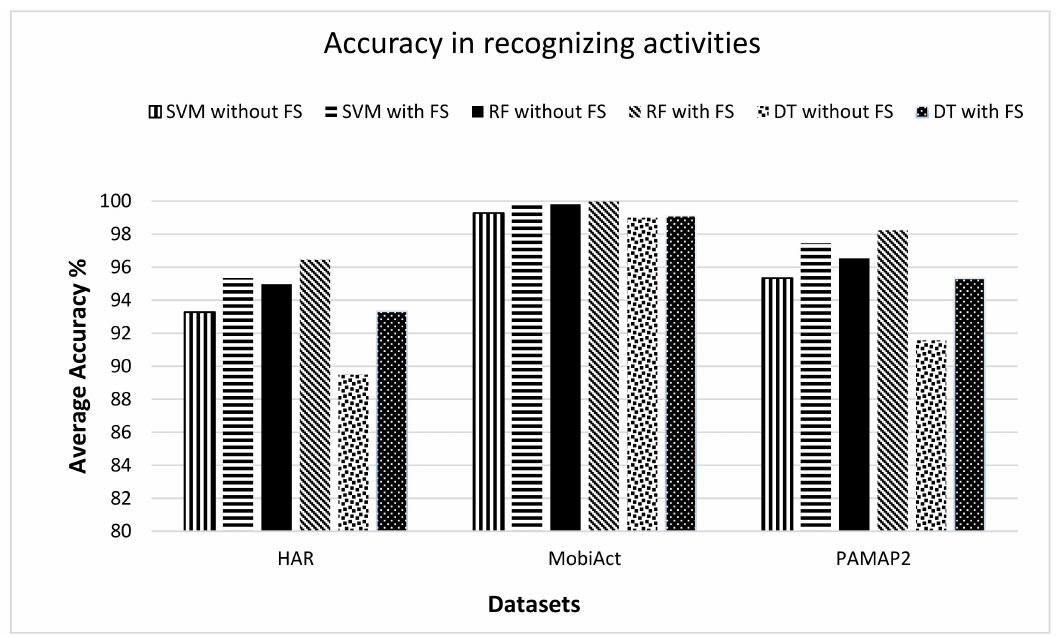
Figure 8. Comparison of average accuracy for the SVM, RF, and DT classifier with and without feature selection (FS) on selected datasets based on activity